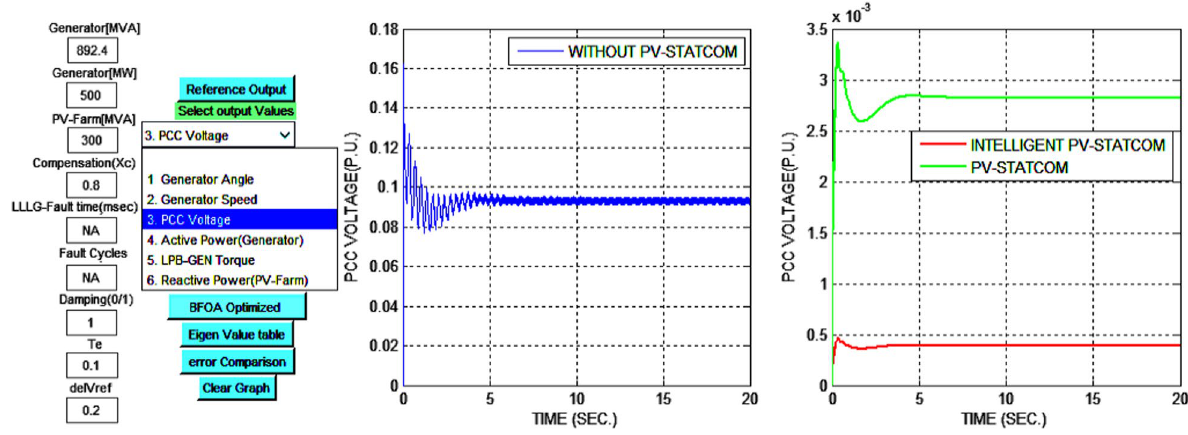
Fig. 18 Coupling voltage deviation (ΔV)